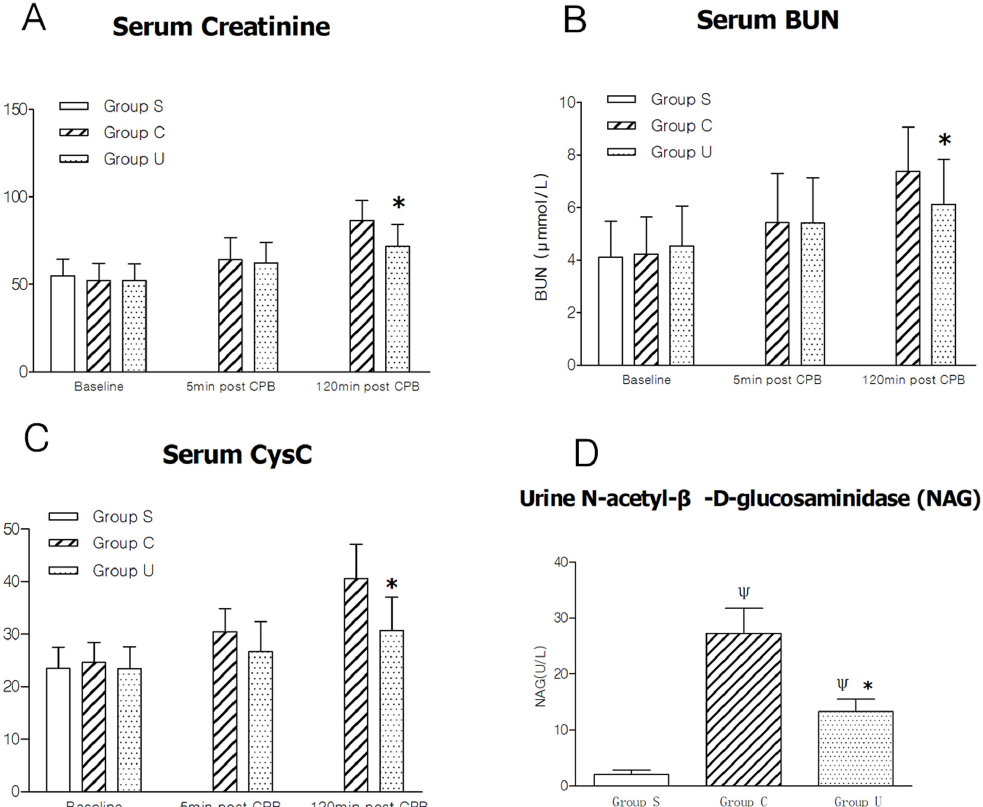
Fig 2. Results of markers of kidney injury in the three groups. (A) serum creatinine; (B) serum BUN; (C) serum CysC; (D) urine NAG, urine N-acetyl- β -D- glucosaminidase. Data are presented as mean ± SD, n = 6, * P < 0.05 versus Group C, Ψ P < 0.05 versus Group S. For graphs pooled estimates for pairwise comparisons derived from Analysis of Covariance with adjustment for baseline serum creatinine at 53.61 ± 9.53 μ mmol/L, serum BUN 4.31 ± 1.34 μ mmol/L, serum CysC 24.35 ± 4.2 μ g/L, were as follows: serum creatinine; 5min post CPB(T2): Group C, 64.24 ± 12.53 μ mmol/L, Group U, 62.33 ± 11.73 μ mmol/L. Test for overall treatment effect P = 0.074. 120min post CPB(T3): Group C, 86.62 ± 11.41 μ mmol/L, Group U, 71.72 ± 12.55 μ mmol/L. Test for overall treatment effect P = 0.032. serum BUN; 5min post CPB(T2): Group C, 5.43 ± 1.87 μ mmol/L, Group U, 5.41 ± 1.72 μ mmol/L. Test for overall treatment effect P = 0.081. 120min post CPB(T3): Group C, 7.37 ± 1.72 μ mmol/L, Group U, 6.13 ± 1.69 μ mmol/L. Test for overall treatment effect P = 0.025. serum CysC; 5min post CPB(T2): Group C, 30.47 ± 4.4 μ g/L, Group U, 26.66 ± 5.7 μ g/L. Test for overall treatment effect P = 0.069. 120min post CPB(T3): Group C, 40.62 ± 6.5 μ g/L, Group U, 30.72 ± 6.2 μ g/L. Test for overall treatment effect P = 0.001.